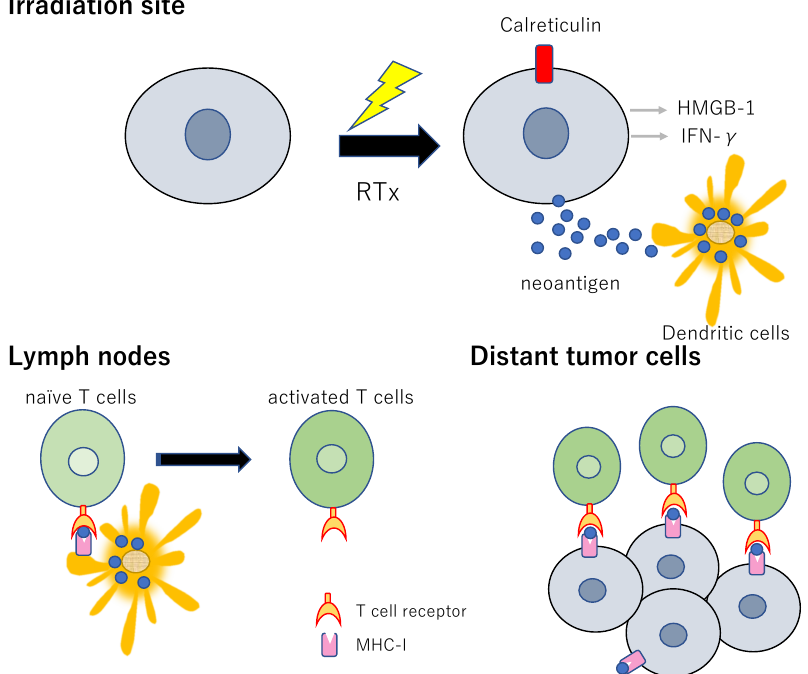
Figure 4. Mechanisms by which radiation enhances the immune response. Cancer-specific peptides released from radiation-damaged cancer cells facilitate the uptake and presentation of antigens by dendritic cells. The radiation enhances the pro-phagocytosis signal (calreticulin) that mediates phagocytosis by macrophages and dendritic cells, thereby increasing the presentation of antigens and the priming of T cells. Following radiation, damaged DNA is released from the nucleus into the cytosol, triggering the cGAS–STING pathway, which activates interferon gene transcription. Due to the stress response, irradiated tumor cells release various mediators, such as IFN γ and HMGB-1. IFN γ upregulates the MHC-I expression on tumor cells and APCs (antigen-presenting cells), including macrophages and dendritic cells. The APCs interact with tumor antigens and then migrate to the lymph nodes, where they present antigens to T cells, a process that is mediated by the MHC pathway and is enhanced by HMGB-1. T cells, especially CD8 + T cells, are activated and begin to propagate. As a result, activated e ff ector T cells exit the lymph nodes and home to the tumors, including both the primary tumors and non-irradiated tumor metastases, to exert their killing e ff ect. The upregulation of MHC-I expression on tumor cells after irradiation facilitates the recognition of the tumor cells by T cells. Poleszczuk et al. generated a mathematical model to predict the immune-mediated abscopal e ff ects [113]. To construct the model, they hypothesized that abscopal responses can only be achieved if T cells activated at one tumor site approach each of the other metastatic sites in su ffi cient numbers. In addition, they assumed that tra ffi cking of activated T cells from the site of activation (the irradiated tumor) to a particular organ containing metastatic tumor cells is potentially determined on the basis of physiological blood flow to that organ and by the initial imprinting of T cells by tumor antigen-presenting dendritic cells. Success in triggering the abscopal e ff ect depends, at least in part, on which metastatic site is selected for radiotherapy. Using these parameters, they calculated